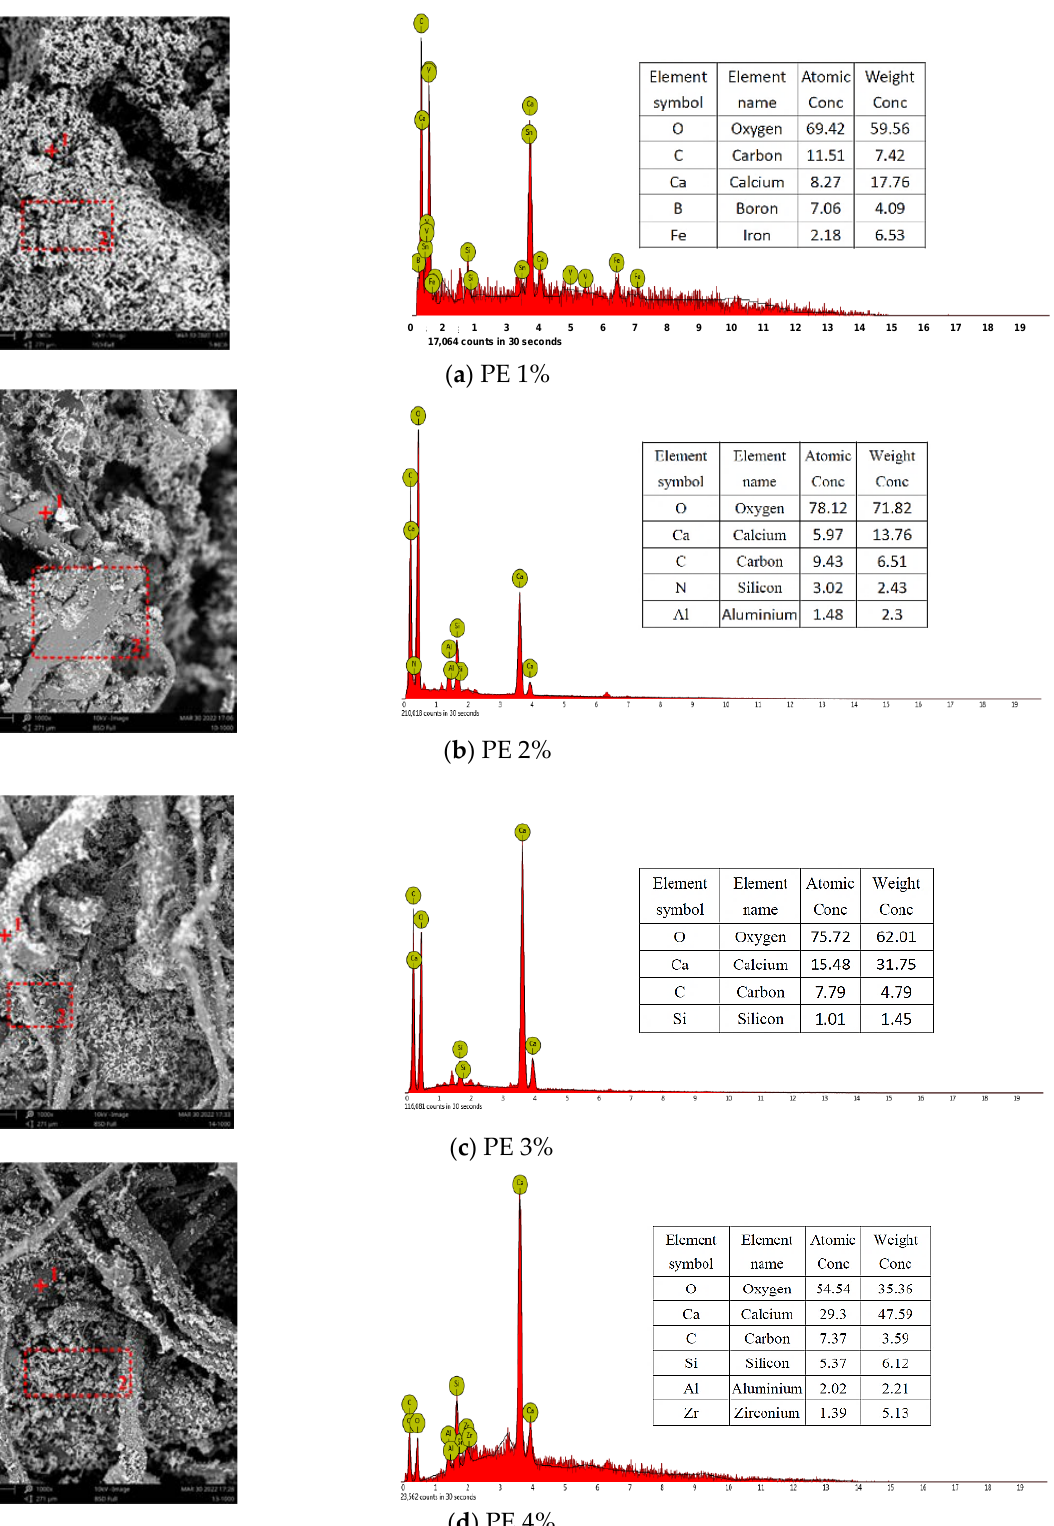
15 of 19 Figure 11. Resistance to sulfate attack of cement mortar with different W/B ratios and waste PE.